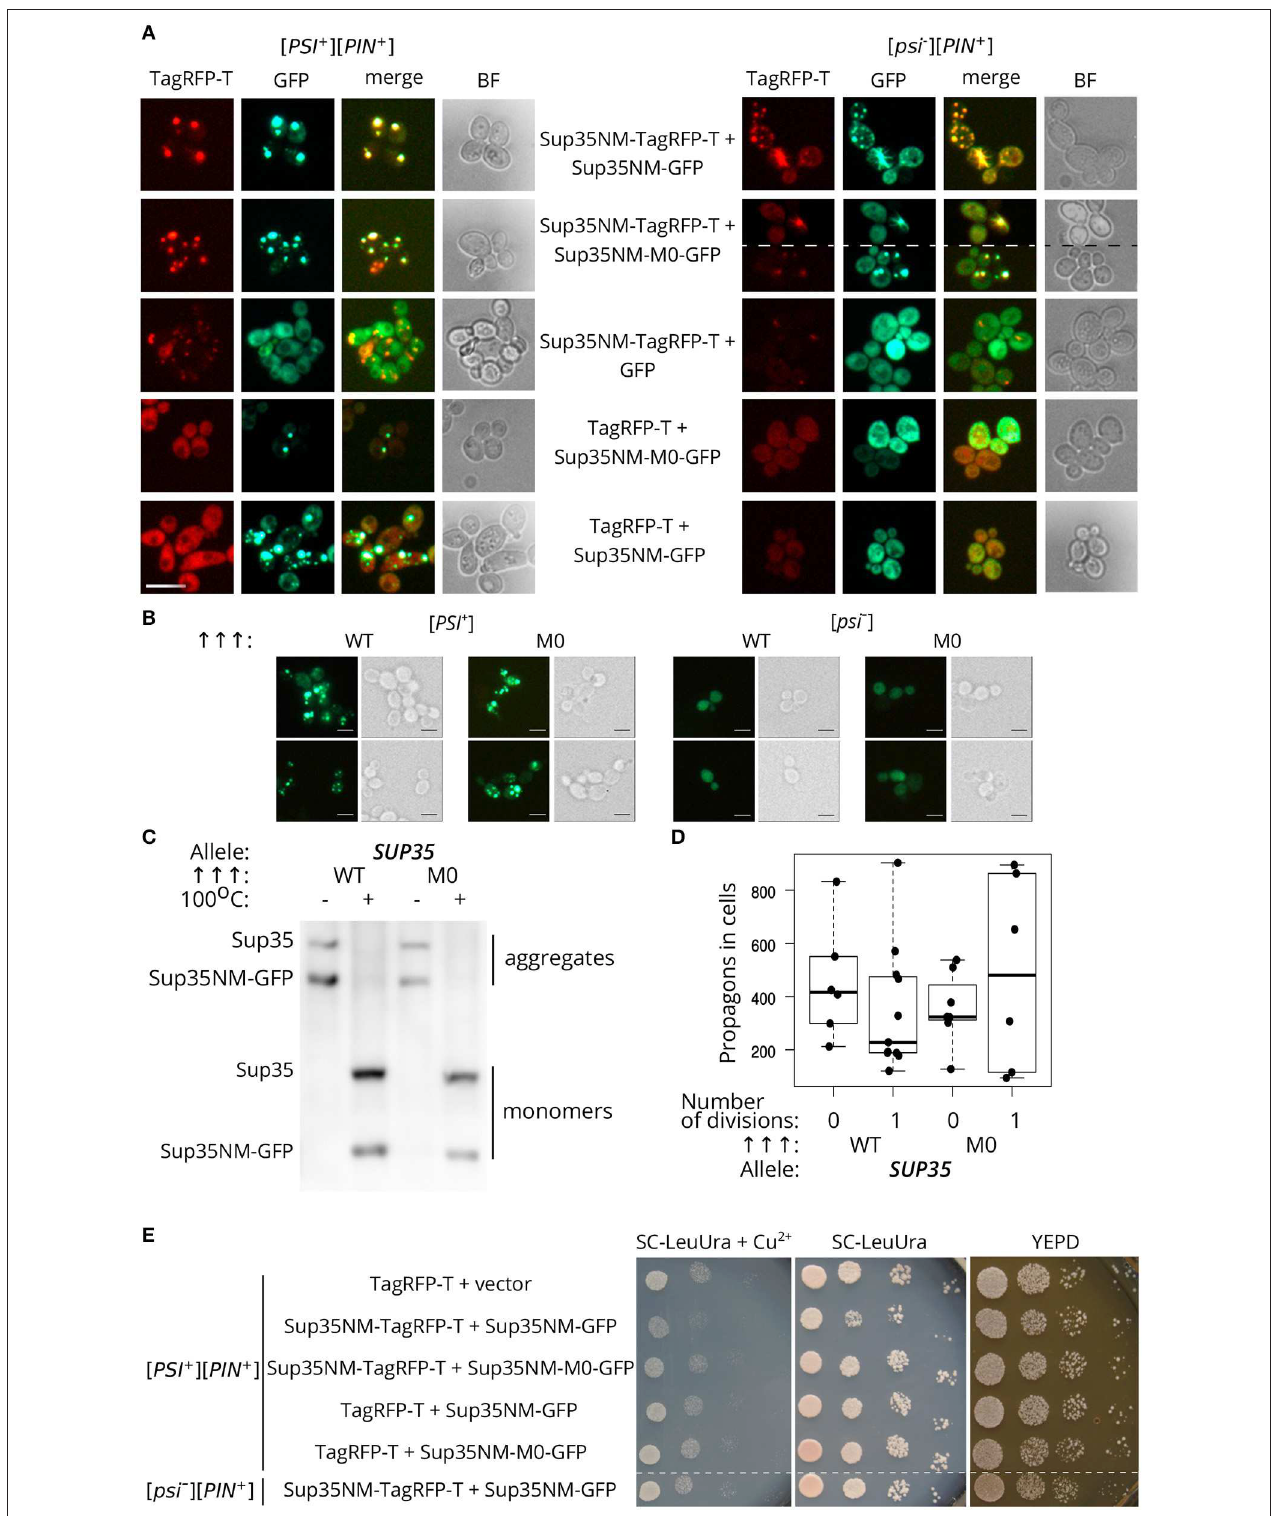
FIGURE 5 | The Sup35-M0 protein can incorporate into fibrils of wild-type protein in vivo . (A) [ psi – ][ PIN + ] (74-D694) and [ PSI + ][ PIN + ] (P-74-D694) yeast strains were transformed with the plasmids for overproduction of Sup35NM-yTagRFP-T, in combination with either Sup35NM-GFP or Sup35NM-M0-GFP. We observed that